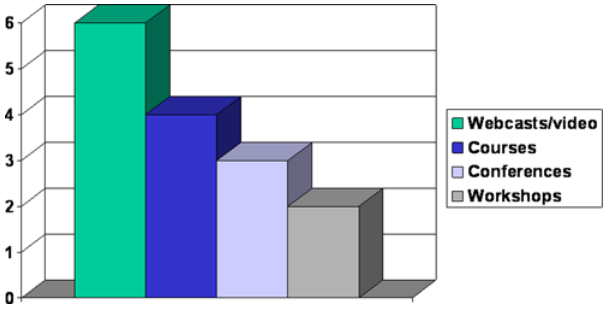
Figure 1. Types of training events held in Peru, 2004–2007.